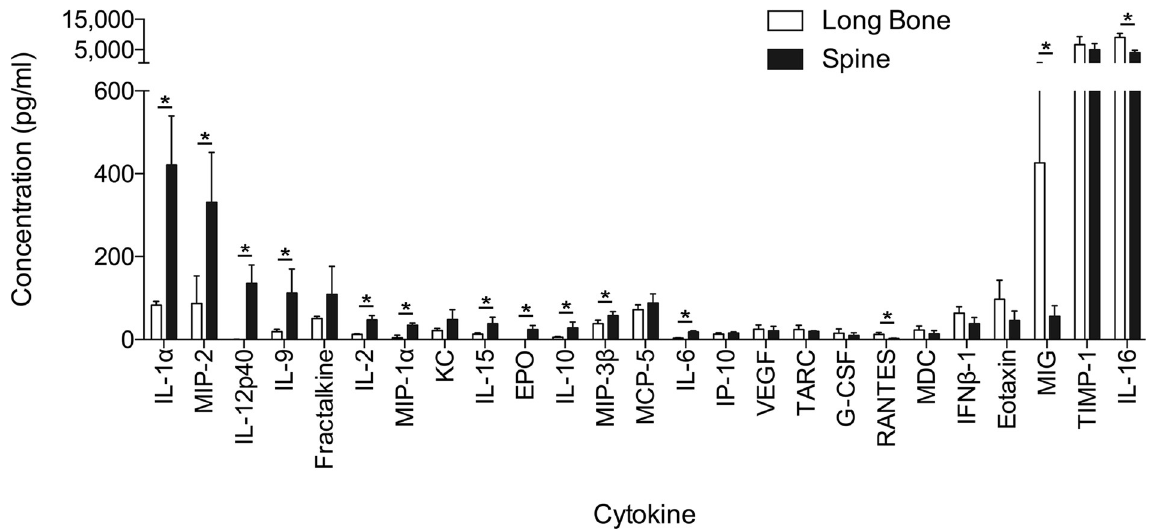
Fig 3. Differential expression of cytokines is based on bone marrow location. Forty-four mouse cytokines were analyzed between murine vertebral body and long bone. Values with concentrations > 10 pg/mL are displayed as mean ± SD. Statistical significance equals p � 0.05.